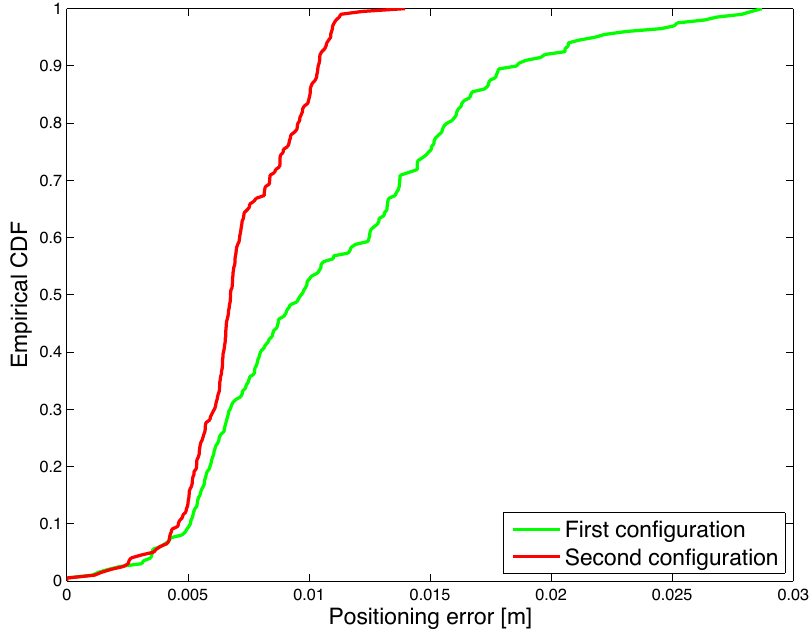
Figure 13. Experimental results: CDF of the positioning error under two orientation configurations. The green line (first configuration) is related to the test performed with initial orientation of transmitter coil a = 0, b = 0 and c = 1, the red line (second configuration) is related to the test performed with the initial orientation of transmitter coil a = 0.72361, b = − 0.52573 and c =